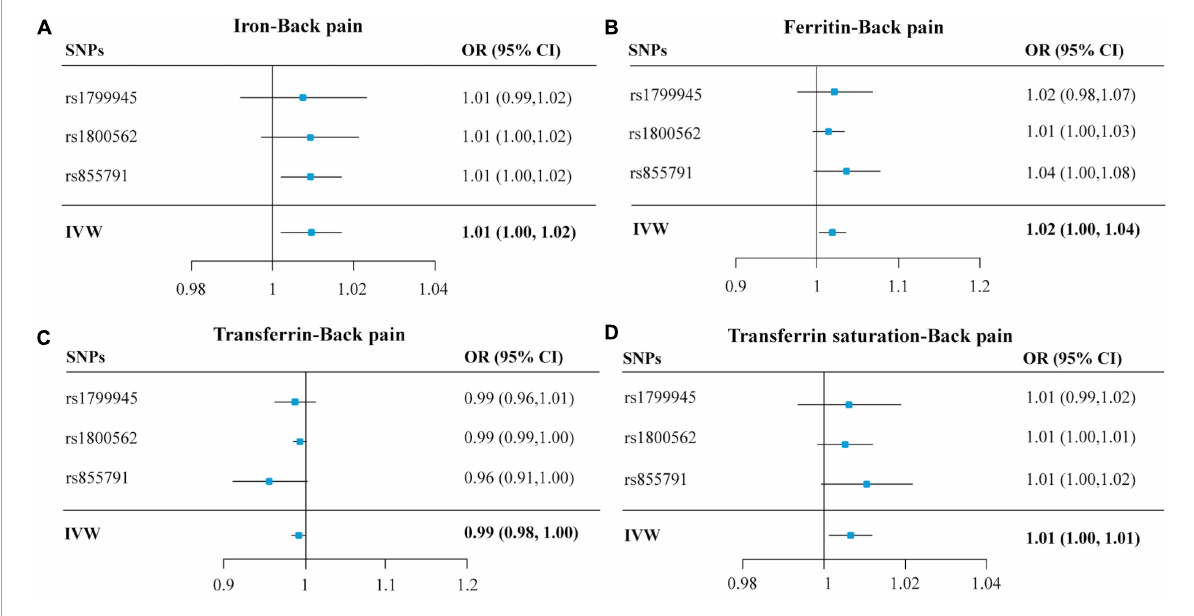
FIGURE2 Forest plots summarizing the SNP-specific and overall MR estimates for the causal effects on back pain using the SNPs associated with four iron biomarkers in conservative analyses. Panels (A–D) , respectively, indicate the causal estimates of serum iron, ferritin, transferrin, and transferrin saturation on back pain. The horizontal lines represent the 95% CIs, while the solid black diamonds represent estimates of the causal effects of the genetic instruments. The gray diamond’s center indicates the overall MR estimate, while the diamond’s width indicates the 95% CIs. MR, Mendelian randomization; SNP, single nucleotide polymorphisms; OR, odds ratio; CI, confidence interval; IVW, inverse variance